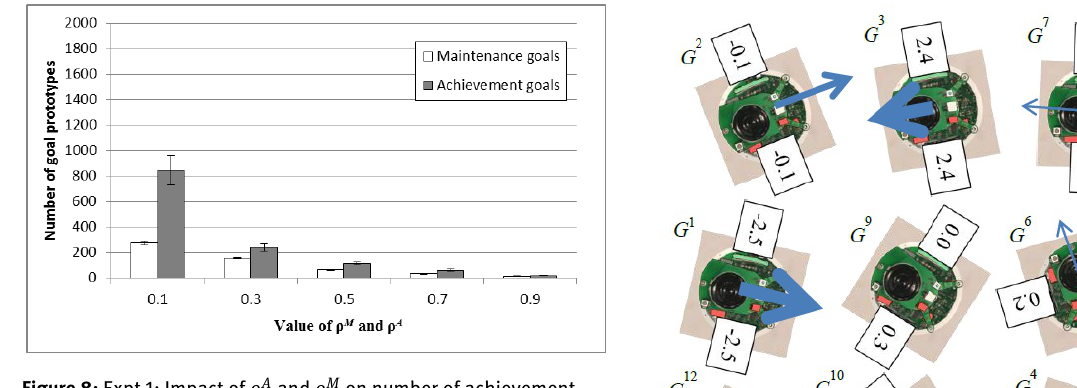
Figure 8: Expt 1: Impact of ρ A and ρ M on number of achievement (grey) and maintenance goals (white) generated.